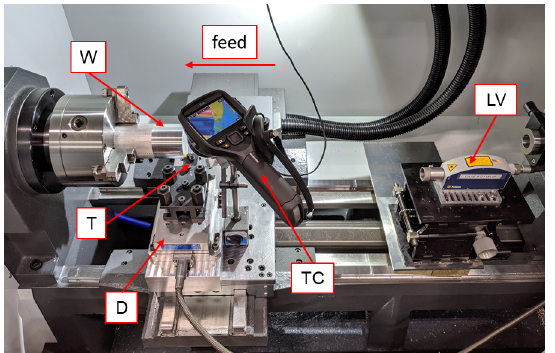
Figure 6. Photograph of turning setup including workpiece (W), dynamometer (D), cutting tool (T), thermal camera (TC), and laser vibrometer